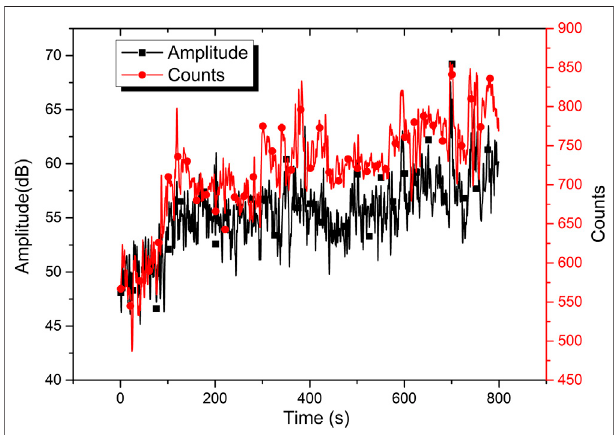
FIGURE 5 | The trends of parameters with PF (cid:2) 30 Hz, VP (cid:2) 35%.